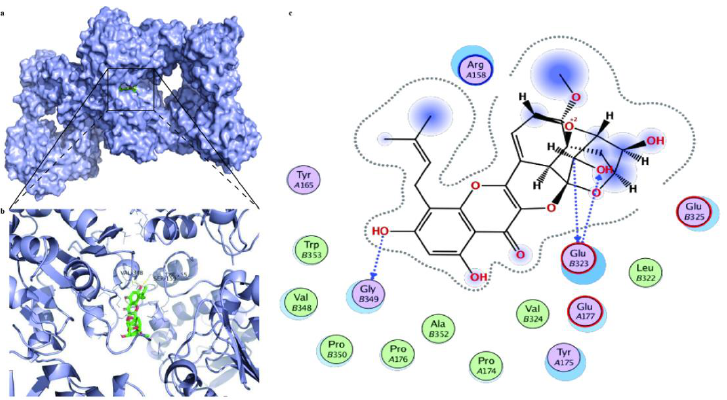
Figure 9. The molecular docking results of ICS II with the SIRT3 complex: ( a ) the whole view of the ICS II dimer and SIRT3 displaying the molecular binding pocket; ( b ) crystal structure of ICS II (green) displaying SIRT3 (blue) bound to the docking pocket; ( c ) residues of amino acids between ICS II with the SIRT3 complex.